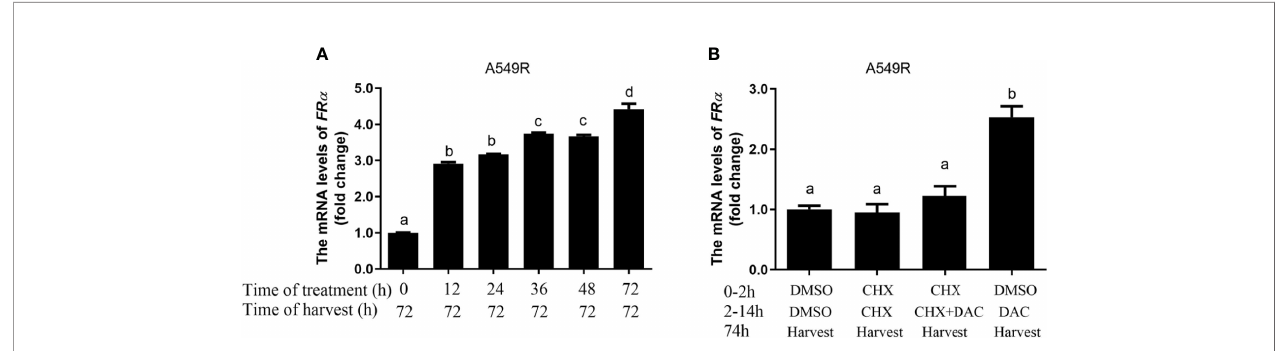
FIGURE 4 | Decitabine delayed the induction of FR a expression in A549R cells. (A) The fold change in the expression of the FR a mRNA in A549R cells treated with 0.5 m M decitabine for the indicated periods. After decitabine treatment, cells were washed with decitabine-free media and replenished with new media that did not contain decitabine. At 72 h, all cells were collected for mRNA extraction. (B) A549R cells were pretreated with cycloheximide (CHX; 10 m M) followed by decitabine (DAC; 0.5 m M) as indicated. Twelve hours later, the cells were washed with decitabine/cycloheximide - free media and replenished with new media that did not contain decitabine/cycloheximide. All cells were harvested 60 h later, and total RNA was extracted for the quanti fi cation of the FR a mRNA by using RT-qPCR. Data are presented as the means ± SE, n =3. Treatment groups with different letters show statistically differences using ANOVA followed by Tukey ’ s